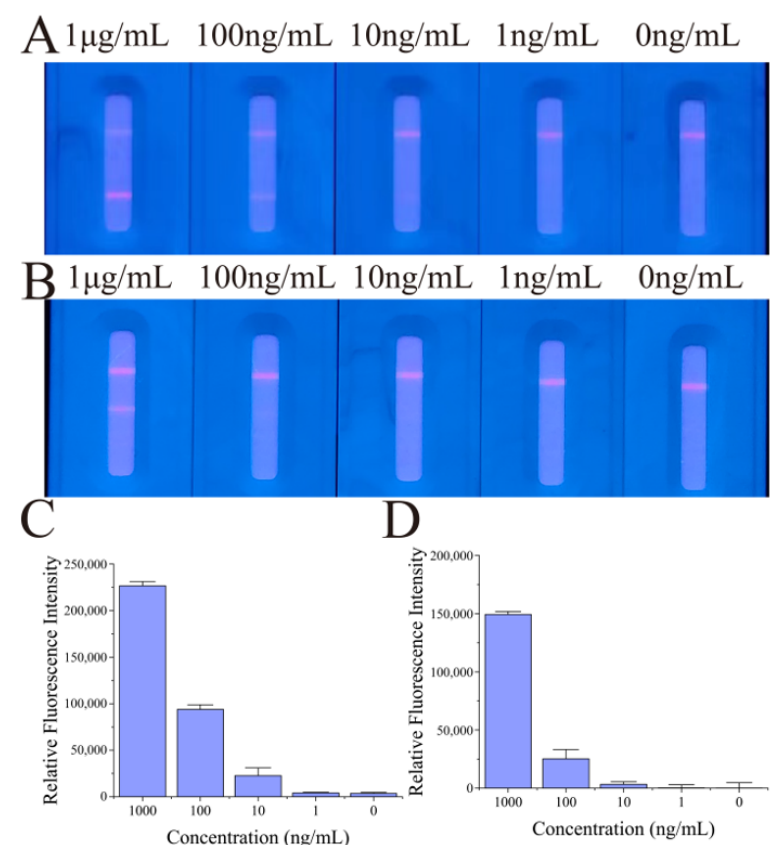
Figure 5. The performance of the FluB/SARS-Cov-2 QDFM ICTS. ( A ) The test of different concentrations of FluB recombinant antigen. ( B ) The test of different concentrations of SARS-Cov-2 N protein antigen. ( C ) The fluorescence analysis of different concentrations of FluB recombinant antigen. ( D ) The fluorescence analysis of different concentrations of SARS-CoV-2 N protein antigen. The images were captured with a smartphone. The analyses were performed using ImageJ.